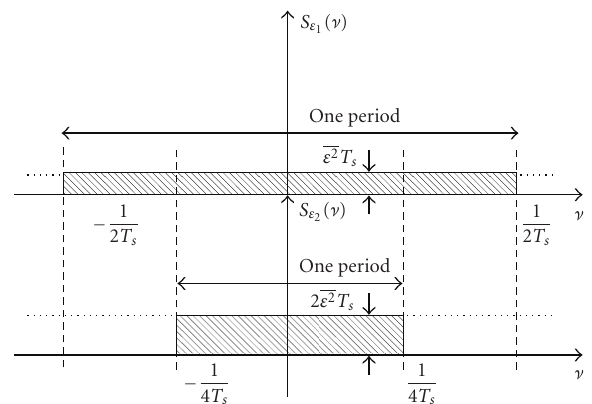
Figure 12: Physical power spectral density of uncorrelated sequences obtained by sampling a continuous stationary random process with sampling rates 1 /T s (top) and 1 / (2 T s )